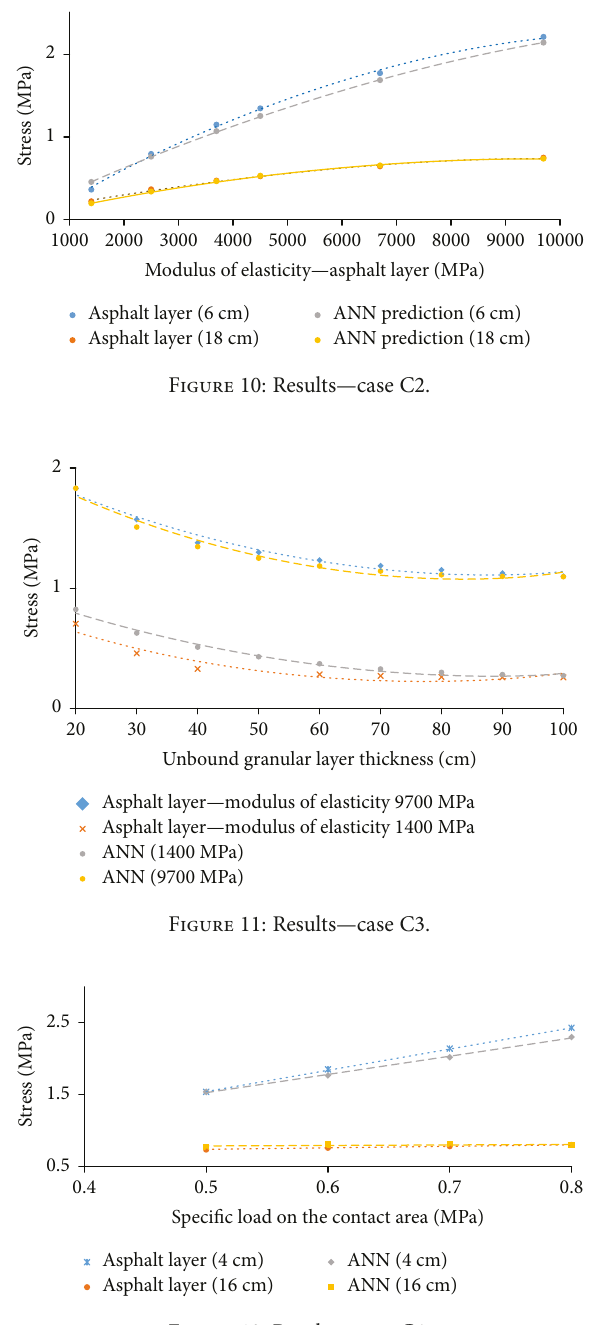
Figure 12: Results — case